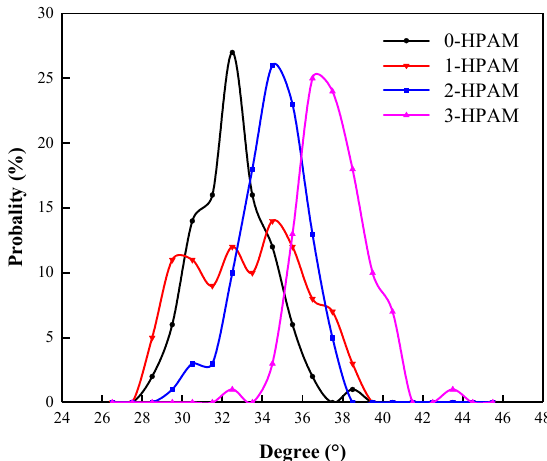
Figure 20. Sectional snapshots of the gas-liquid interface in foam systems with different HPAM concentrations after relaxation equilibrium. ( a ) “0-HPAM” system; ( b ) “1-HPAM” system; ( c ) “2- HPAM” system; ( d ) “4-HPAM” system.